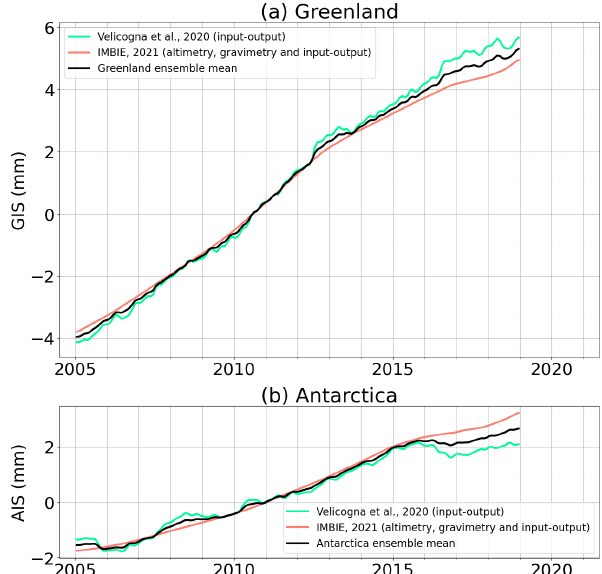
Figure 2. Contributions of the (a) Greenland ice sheet (GIS) and (b) Antarctica ice sheet (AIS) melting to global mean ocean mass change. For each dataset, the method used to estimate the contribu- tion (gravimetry, altimetry or input–output) is indicated in brackets. The black curves correspond to the ensemble means. Linear trends of all time series over different periods of time are provided in Ta- ble